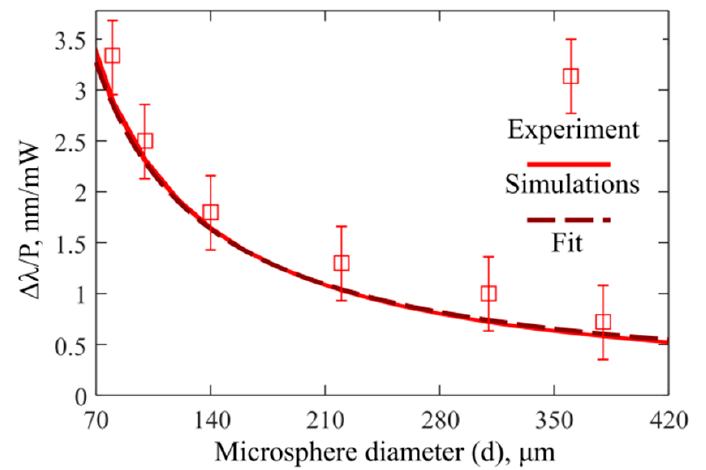
Figure 7. Heat power sensitivity Δ λ / P versus microsphere diameter obtained by experimental measurements, by direct simulations, and fitted by Δ λ / P = C 3 / d , where C 3 = 230 ⸱ nm μ m/mW.